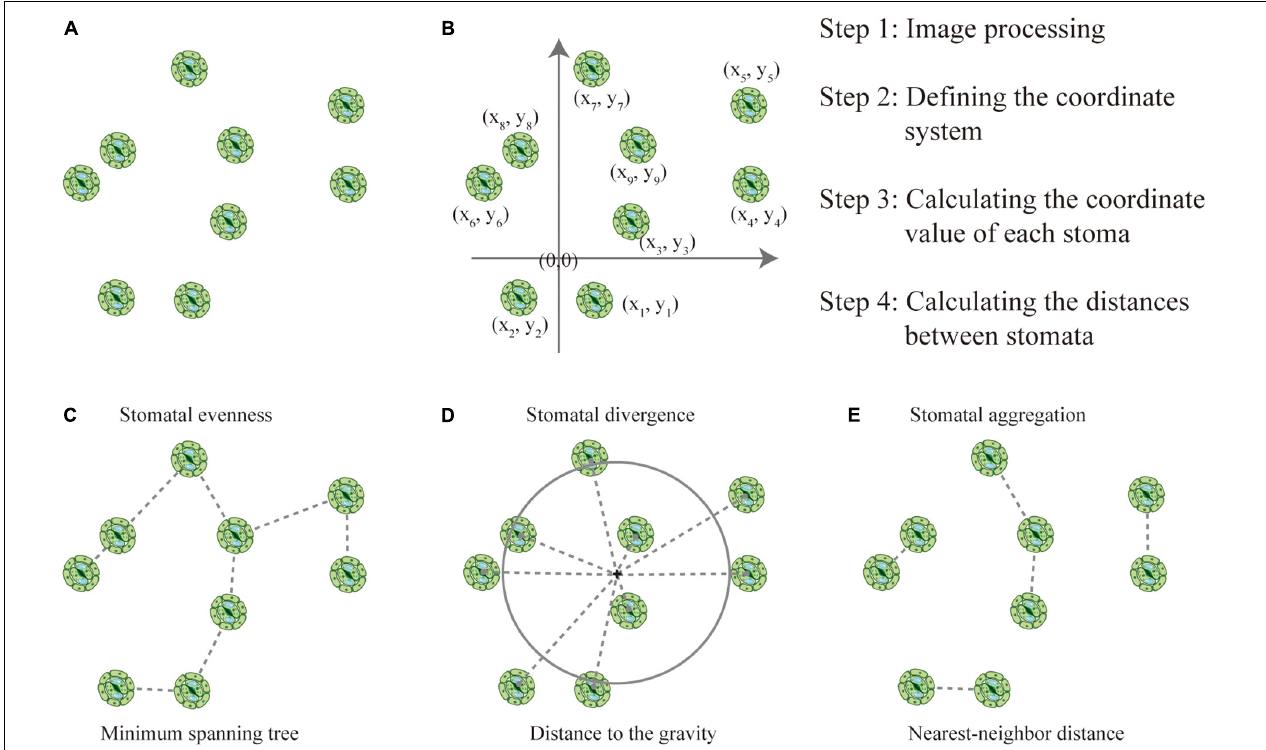
FIGURE 1 | How to quantify stomatal arrangement pattern (SAP) based on the distances between stomata. (A) There is a total of nine stomata in the image, and stomatal density can be calculated as the ratio of the number of stomata to the area of the image. (B) The coordinates were established, and the locations of each stoma and the distances between stomata were quantified. (C) The minimum spanning tree (MST, dashed line) links the stomata. Stomatal evenness can represent the regularity of points along the MST. (D) Stomatal divergence can quantify how stomata diverge in their distances from their center of gravity. The center of gravity of the stomata is marked with a black cross, the gray dashed lines represent the distances of each stoma to the center of gravity, and the large gray circle represents the mean distance to the center of gravity. (E) Stomatal aggregation index was used to test the distribution type of stomata on the leaf surface (i.e., clustered, random, or regularly distributed) based on the nearest-neighbor